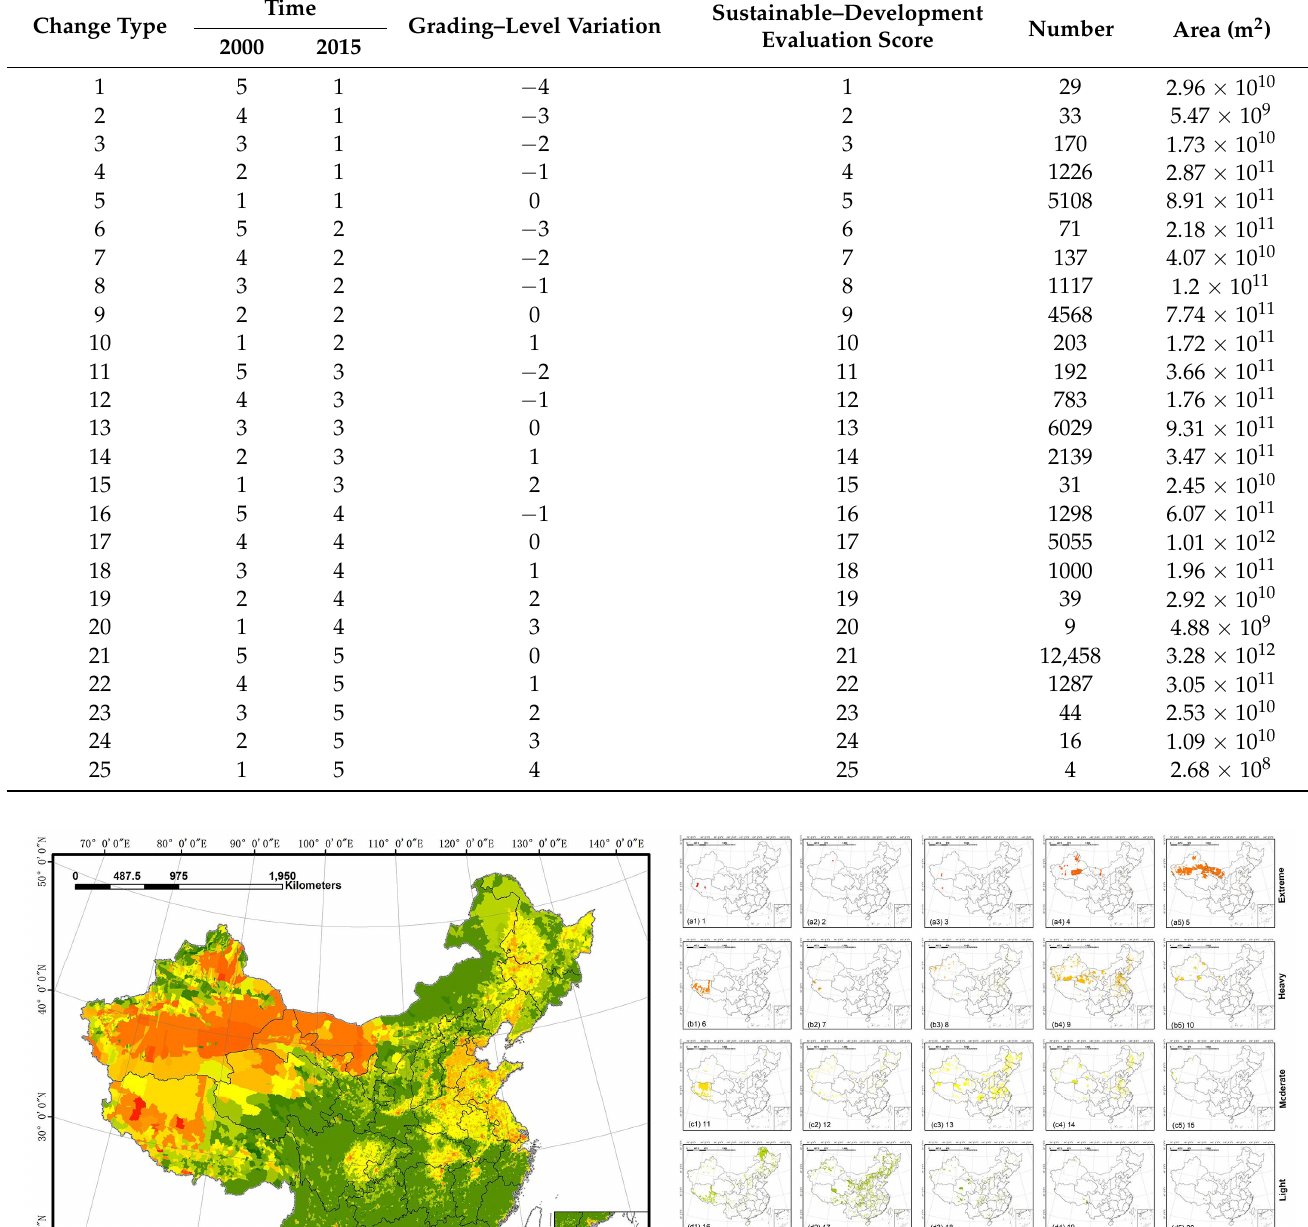
Table 8. Detailed information on the 25 types of variation and the sustainable–development eval- uation score.